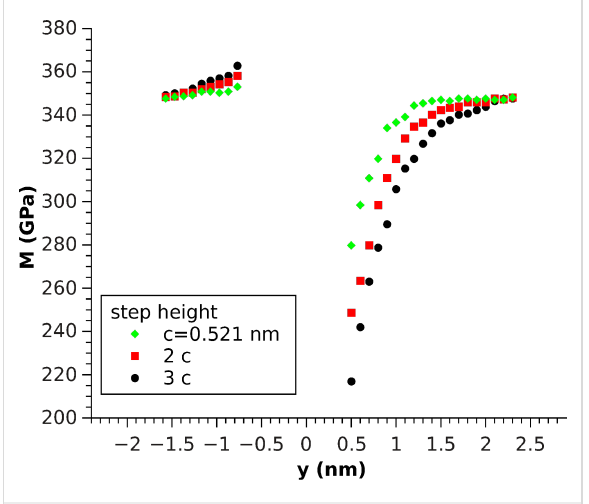
observed in the FEM simulation, seem to nearly compensate in the MD simulation for this contact radius (Figure 4). The decrease of M for y > 0 towards the step looks quite similar in Figure 4 and Figure 6, which indicates that it plays a dominant role in Figure 4 in addition to the effects caused by the role of stress.